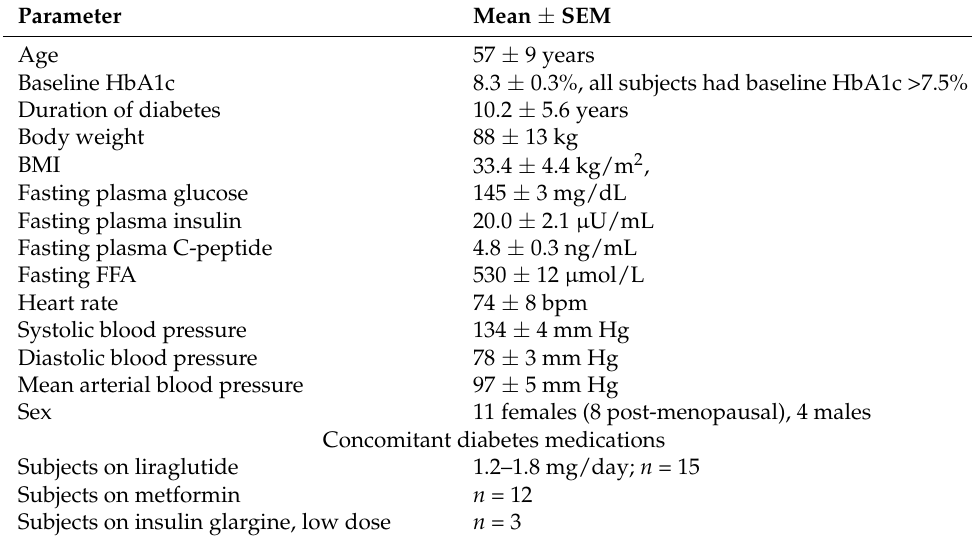
Table 1. Baseline